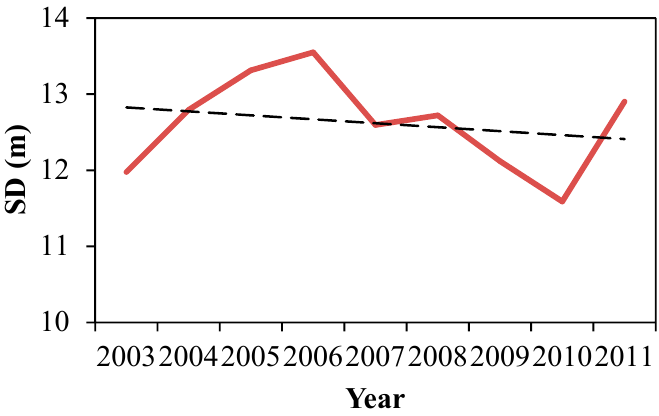
Figure 8. Yearly averaged SD from 2003–2011 in Lake Malawi (red solid line); the black dashed (---) line represents the trend line.